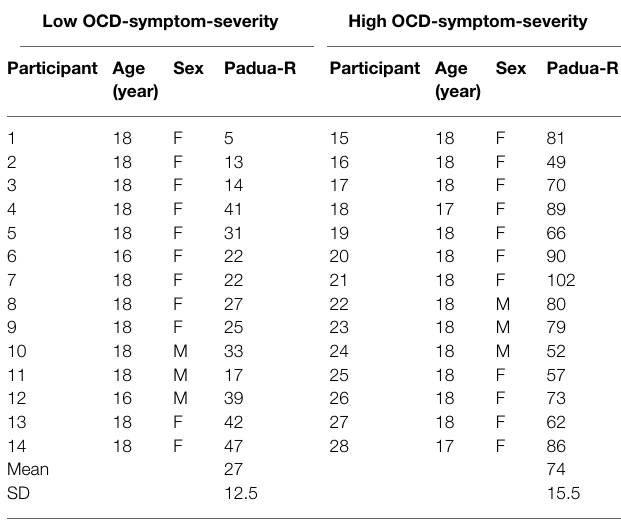
TABLE 1 | Characteristics of participants in the low and high OCD-symptom-severity